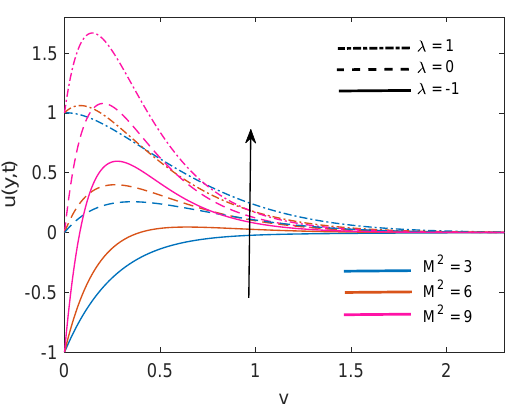
Figure 6. Variation in velocity profile for different M 2 when Nr = 1.5, Gr = 5, K = 5, Q = 0.5, φ = 0.1 and t = 0.5.